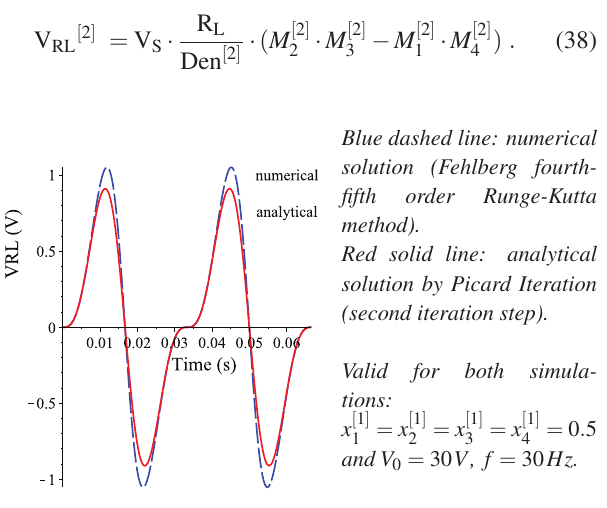
Fig. 14 : V RL dependent on time t, analytical and numerical solution.